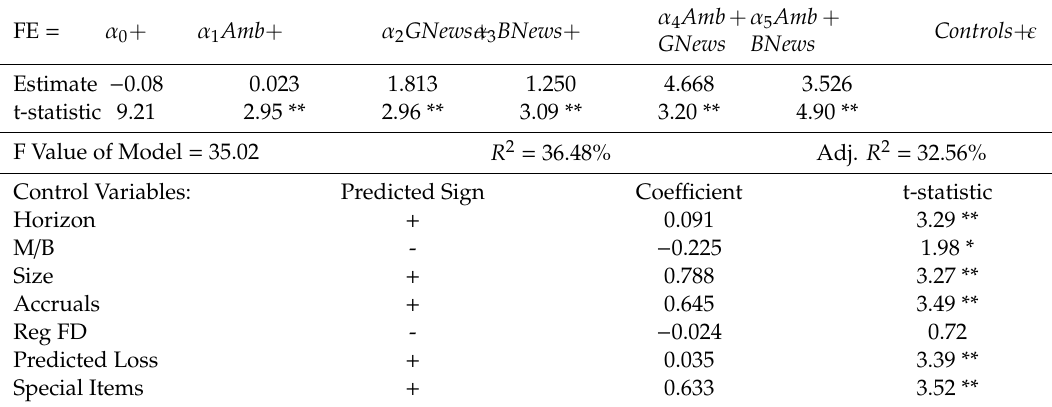
Table 3. The e ff ect of ambiguity on analyst forecast performance.